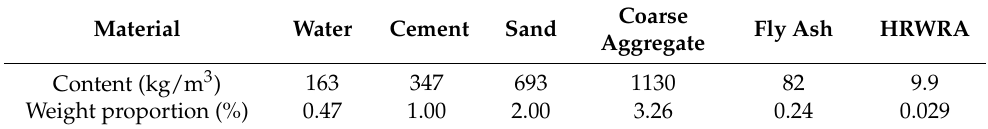
Table 4. Mix proportions of concrete.